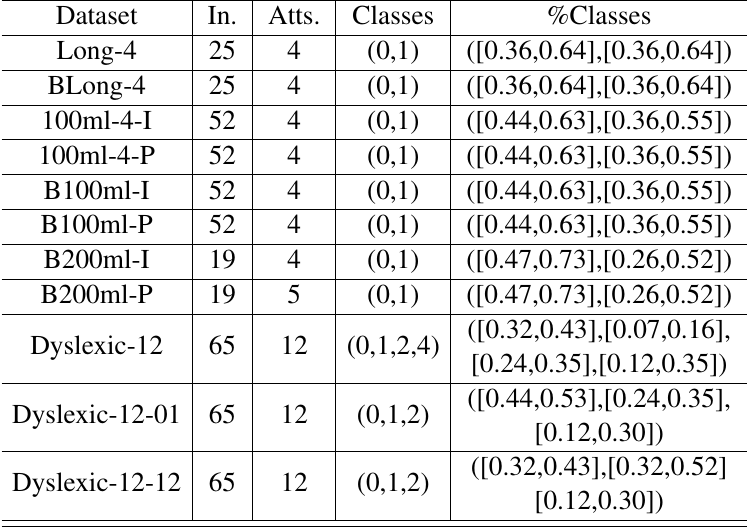
Table 3: Summarized descriptions of the